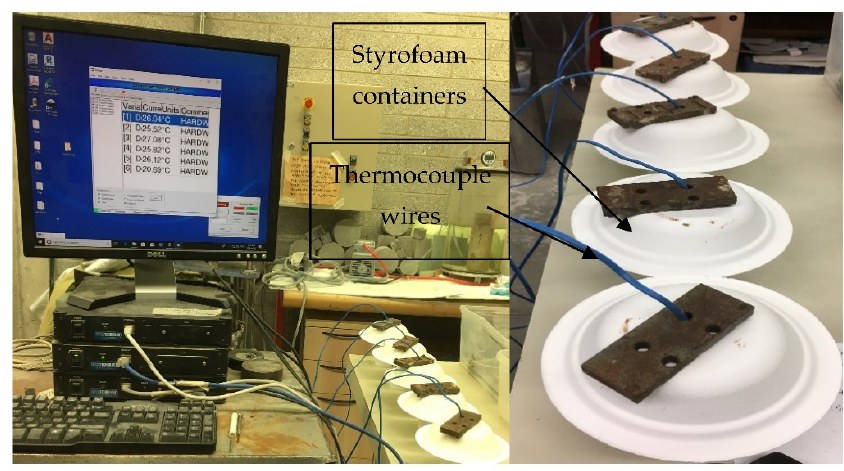
Figure 2. Test set-up for heat evolution.